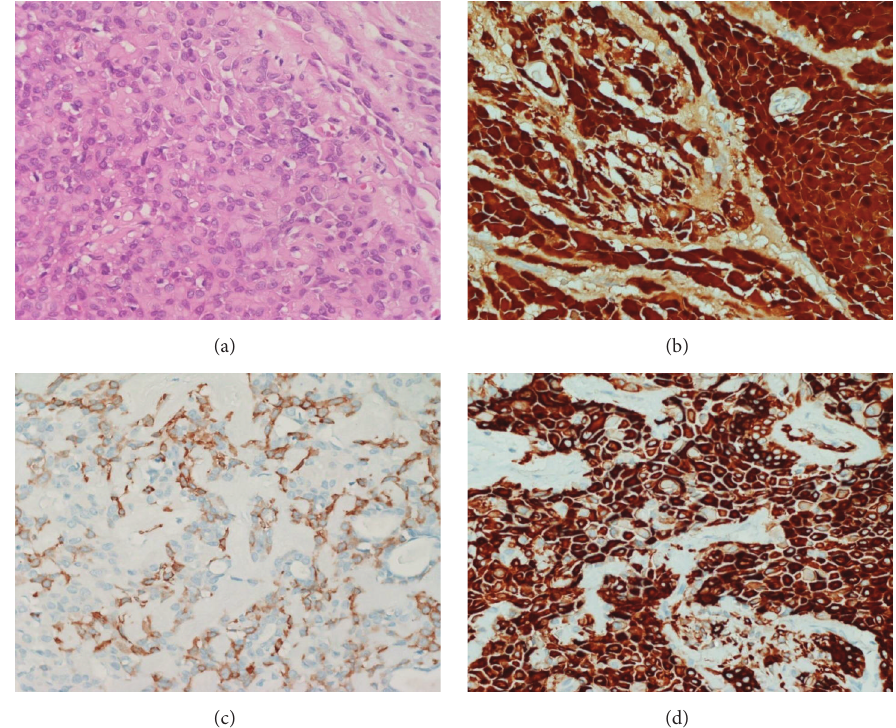
Figure 3: Histological specimens showing solid nests of plasmacytoid cells surrounded by thin fibrous stroma ((a), H&E staining) displaying diffuse immunoreactivity for S-100 (b) and focally for 𝛼 -smooth muscle actin (c) and CK7 (d) ((a–d): magnification